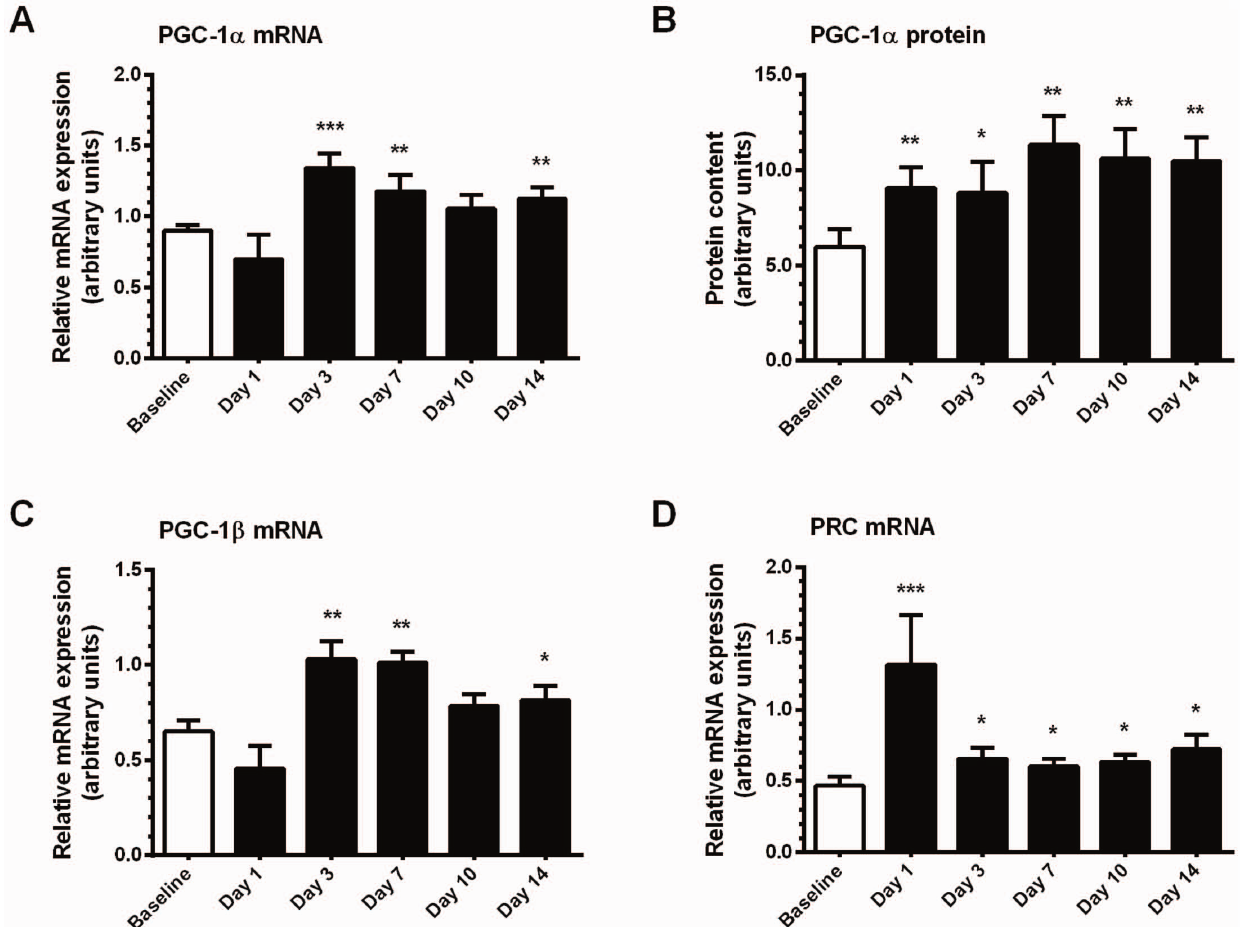
Figure 4. Training-induced alterations in gene expression of members of the PGC-1 family of transcriptional coactivators. A , relative mRNA expression of PGC-1 a . B , protein content of PGC-1 a . C , relative mRNA expression of PGC-1 b . D , relative mRNA expression of PRC. mRNA expression was normalized to the housekeeping gene GAPDH. Values are mean 6 SEM, n=7–8. * trend for a significant difference compared to Baseline (P , 0.1), ** significantly different from Baseline (P , 0.05), *** significantly different from Baseline (P ,